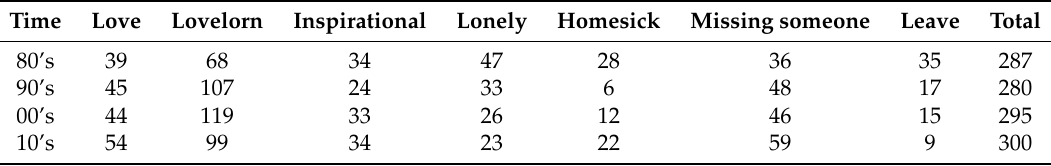
Table 1. Experimental